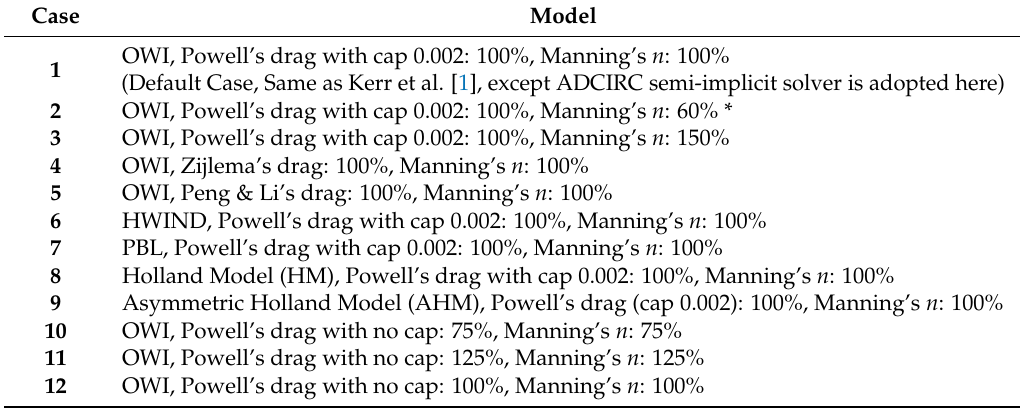
Table 1. Simulations performed using SWAN + ADCIRC (% represents percentage of default case values). Model